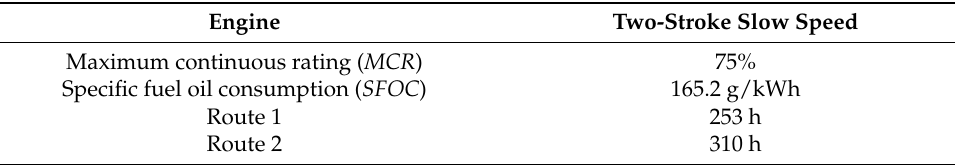
Table 7. Parameters for Route 1 and 2.